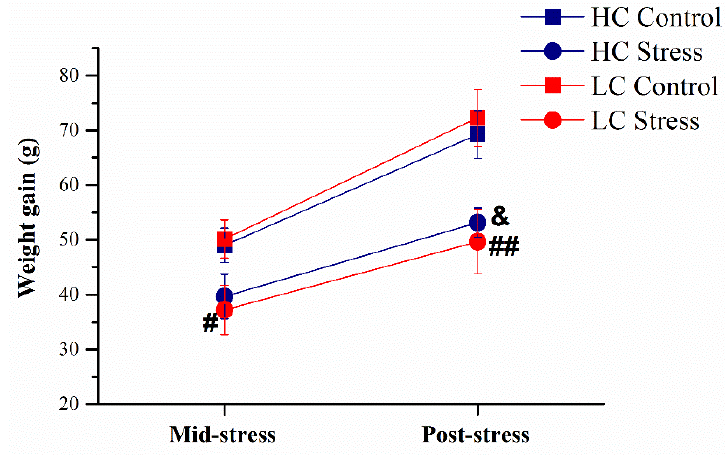
Figure 2. Cumulative weight gain in the middle (day 11 of stress) and after the three-week stress regimen (average ± SEM). #, ## p < 0.05, 0.01 vs. LC-control; and p < 0.05 vs. HC-control. HC-controls: n = 8; HC-stress, n = 8; LC-controls, n = 7; and LC-stress, n = 6. HC, high 50-kHz USV rats, LC, low 50-kHz USV rats.